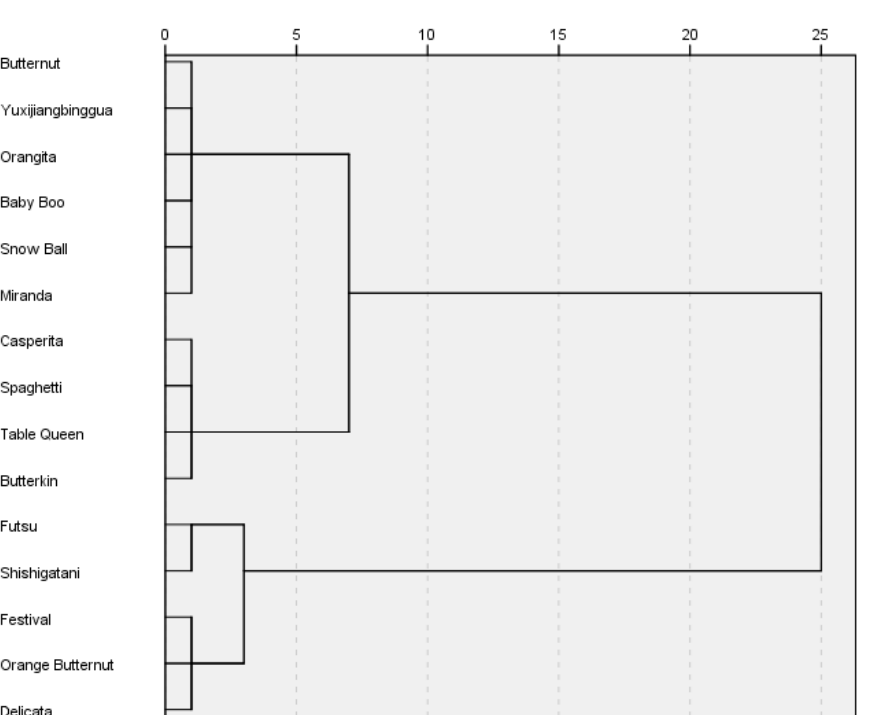
Figure 1. Dendrogram of studied pumpkin variety divisions.